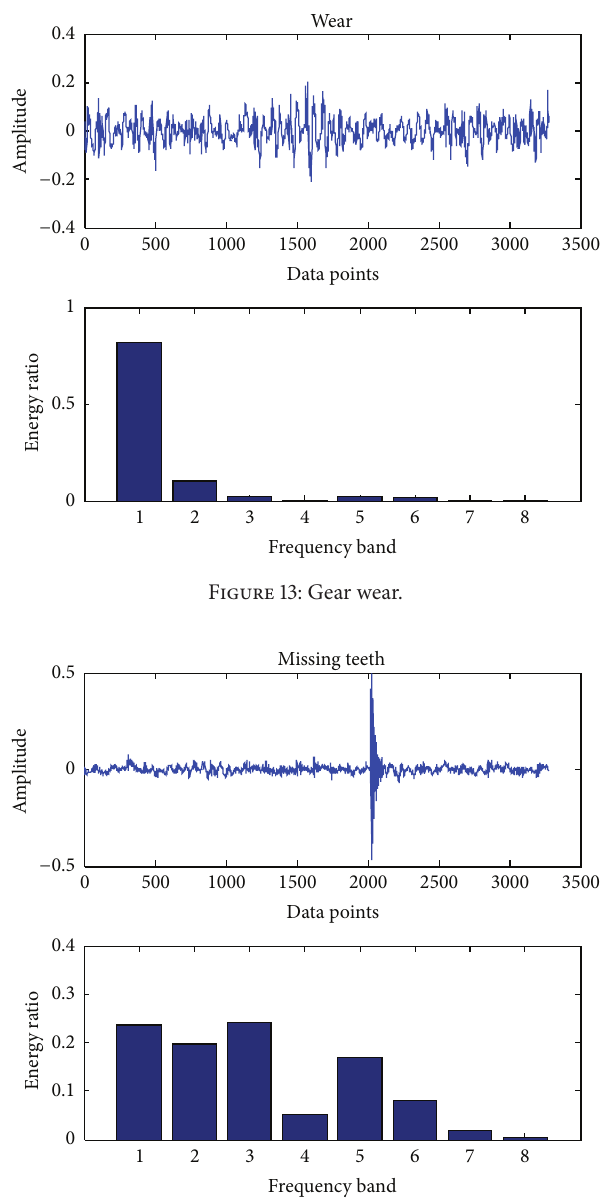
Figure 14: Gear missing